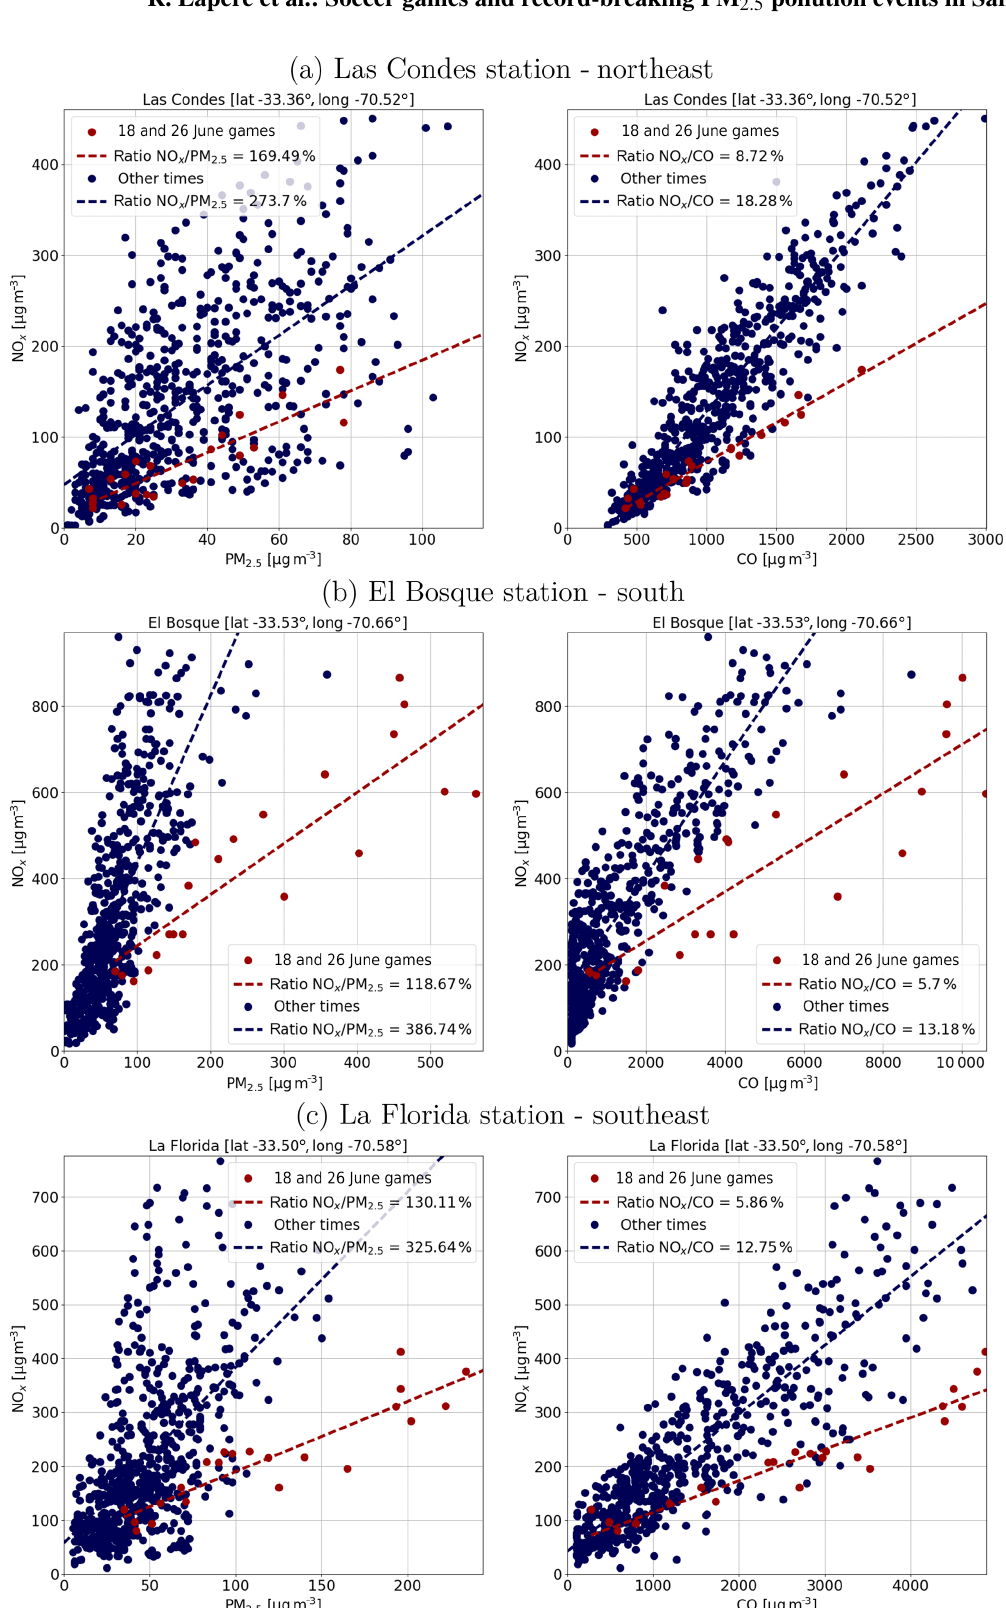
Figure 9. Observed NO x / CO and NO x / PM 2 . 5 concentration ratios at three stations in June 2016. Blue dots are observations during the 18 and 26 June soccer games. Red dots correspond to the rest of the data. Dashed blue and red lines correspond to linear regressions for each